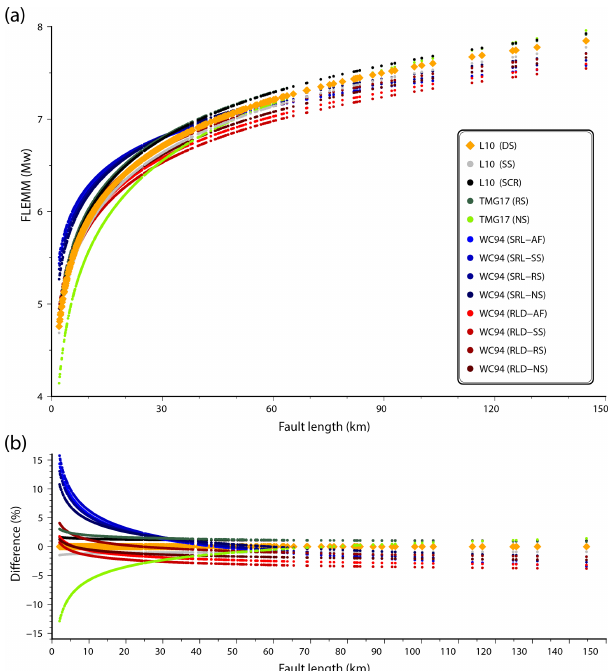
Figure 6. (a) Earthquake magnitude vs. fault length, obtained us- ing empirical scaling relationships: L10–Leonard (2010); WC94– Wells and Coppersmith (1994); and TMG17–Thingbaijam et al. (2017). Keys: DS– dip slip faults; NS–normal slip faults; RS– reverse-slip faults; SS–strike-slip faults; SCR–stable continen- tal region faults; AF–all faults; SRL–surface rupture length; and RLD–sub-surface rupture length. (b) Difference vs. fault length. The difference is between earthquake magnitudes obtained from L10 vs. each of all other scaling relationships (i.e. WC94 and TMG17).